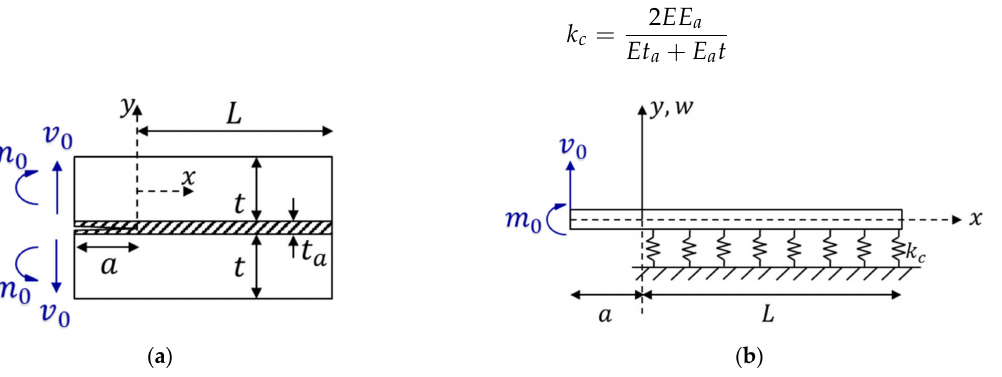
Figure 4. The crack problem definition for Case 1. ( a ) Geometry and load conditions. ( b ) Elastic foundation